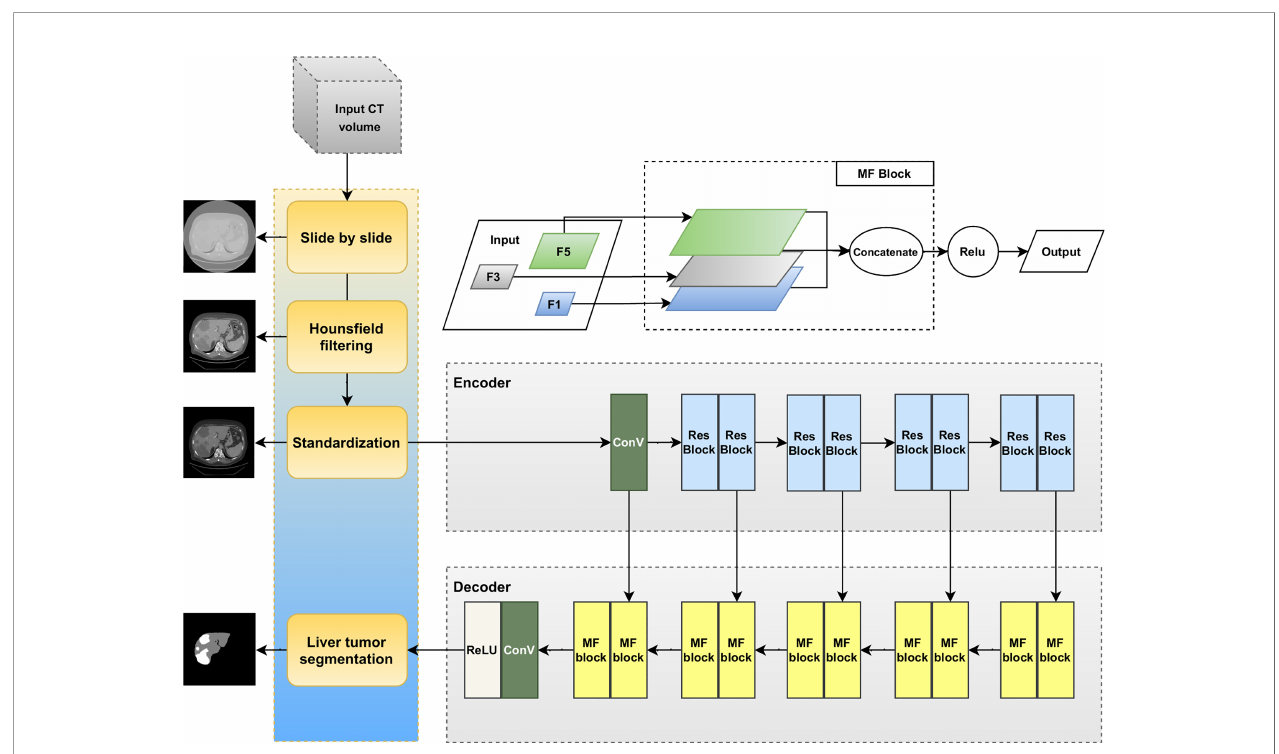
FIGURE 1 | Proposed phases for automatic liver tumor